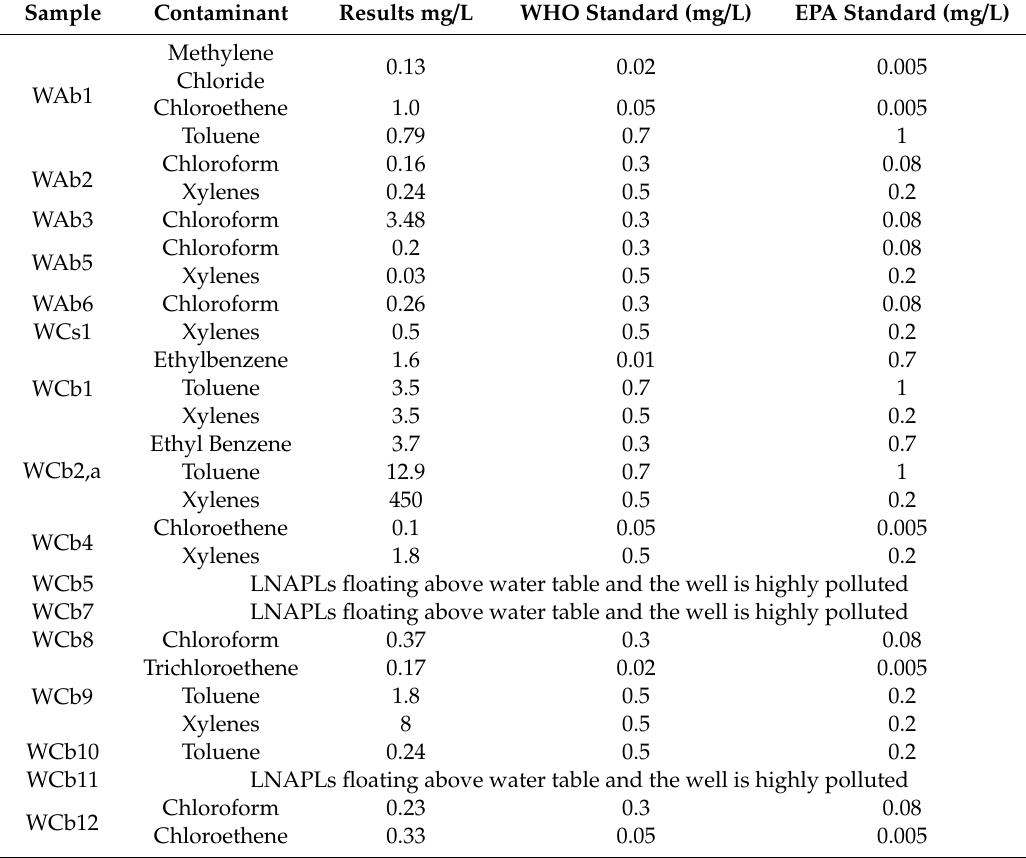
Table 7. Polluted wells with LNAPLs according to the standard given in